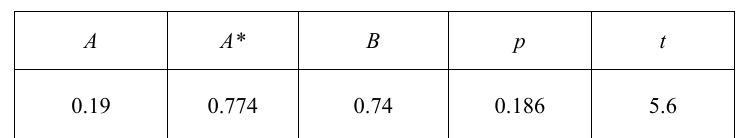
Table 1. Model parameter